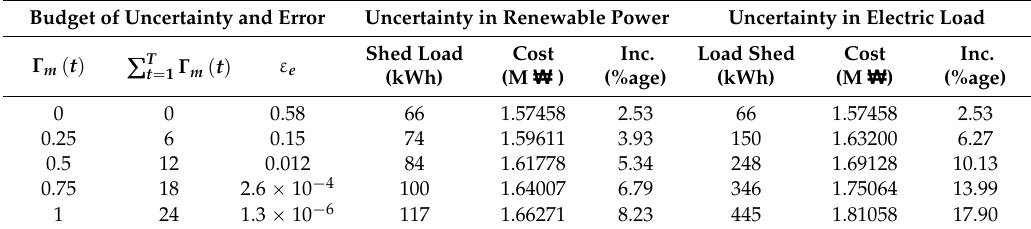
Table 3. Performance in islanded mode with single source of uncertainty. Table 2. Performance in grid ‐ connected mode with single source of uncertainty. Budget of Uncertainty and Error